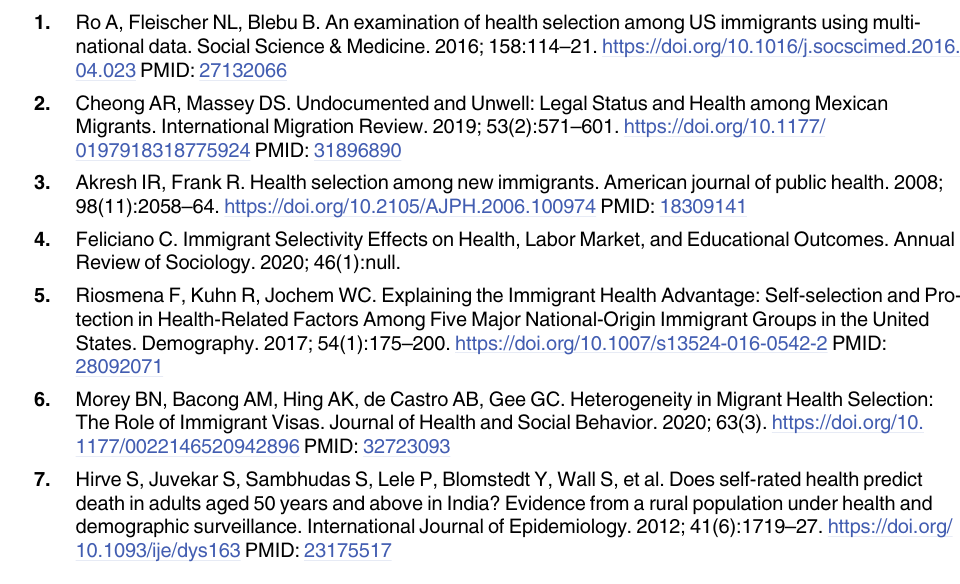
S5 Table. Binary logistic regression of 1-year good/very good/excellent self-rated health on migrant status, Health of Philippine Emigrants Study (HoPES), N = 1194. S6 Table. Ordinal logistic regression of 1-year self-rated health on migrant status, Health of Philippine Emigrants Study (HoPES), N =